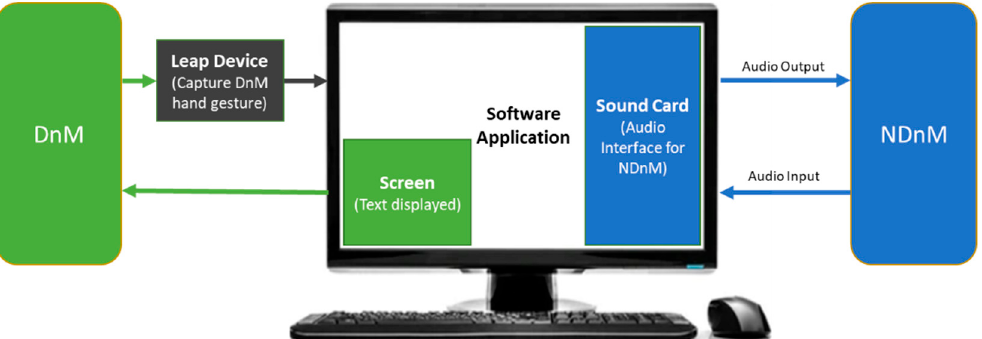
Figure 4. Hardware Interface Block Diagram—Communication between DnM and NDnM.